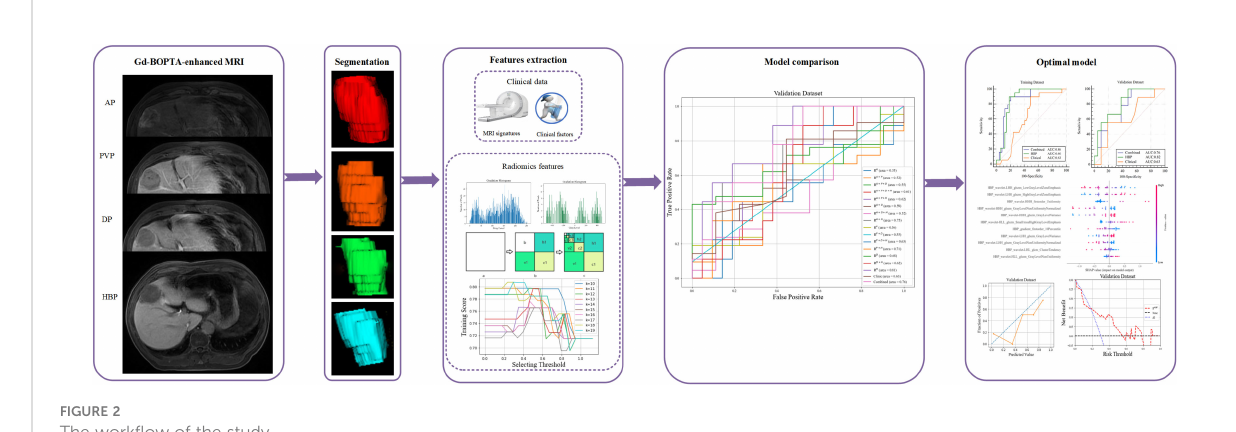
FIGURE 2 The work fl ow of the